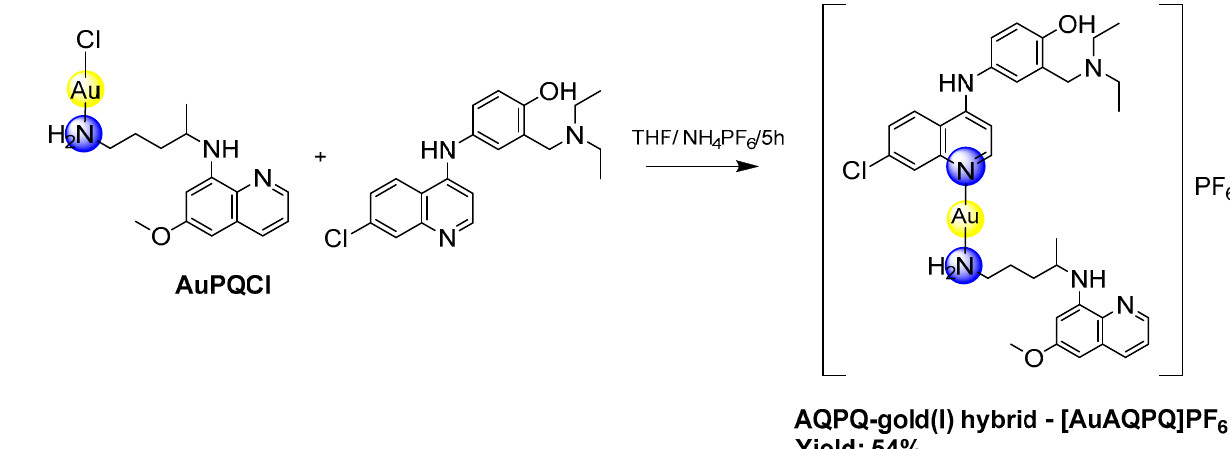
Figure 2. Synthesis of [AuAQPQ]PF 6 ( 2 ).